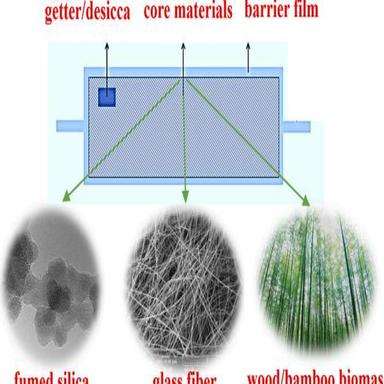
Structure diagram of Vacuum Insulation Panel and the potential core materials used.